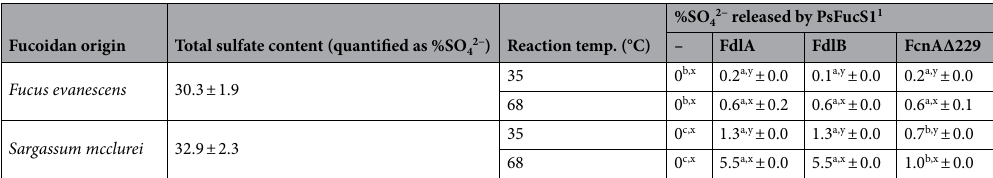
Table 2. Activity of PsFucS1 in combination with or without different fucoidanases on different fucoidan substrates at two different temperatures. – no fucoidanase. 1 Sulfate-release data (%SO 42− released) are given as averages of duplicate assays (data are relative to the theoretical maximum release); different roman superscript letters a–c indicate significantly different values ( p < 0.05) in each row, i.e. in the PsFucS1 reactions together with the different fucoidanases (FdlA, FdlB, and FcnAΔ229), respectively, and different roman superscript letters x–y indicate significantly different values ( p < 0.05) when comparing the two reaction temperatures for each type of fucoidan